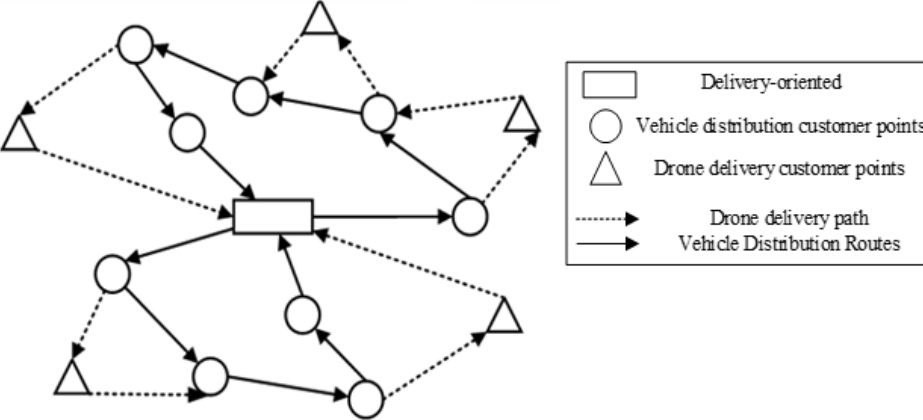
Figure 1. Schematic diagram of coordinated delivery between vehicles and UAVs.